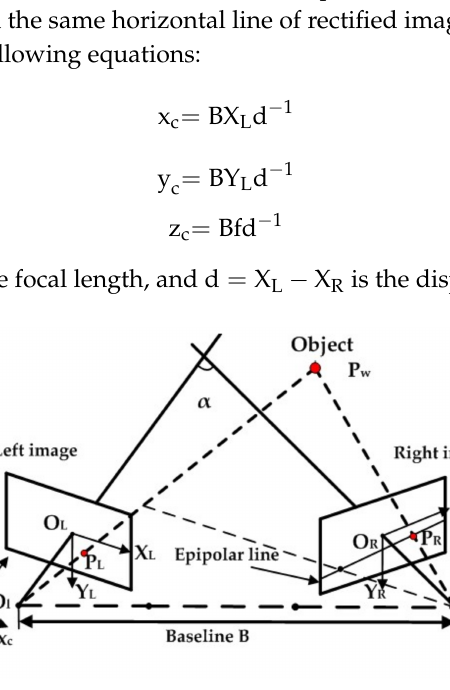
z c and O r − xyz represent the coordinates of the c (cid:1) ,y ,z c ,1 denotes the homogeneous coordinate of object c c ,Y L ,1 ) and P R ( X ,Y R ,1 ) are the homogeneous coordinates L R